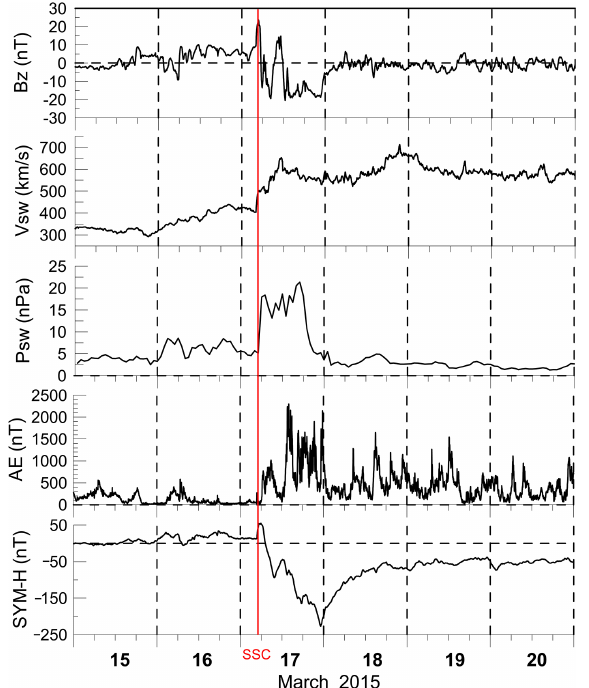
Figure 10. Variations in the interplanetary magnetic field (IMF) and geomagnetic parameters between 15 and 20 March 2015. From top to bottom: IMF Bz component, solar wind speed ( V sw ), solar wind ram pressure ( P sw ), geomagnetic auroral electrojet index (AE) and index of geomagnetic activity (SYM-H). The red line indicates the sudden storm commencement (SSC) time